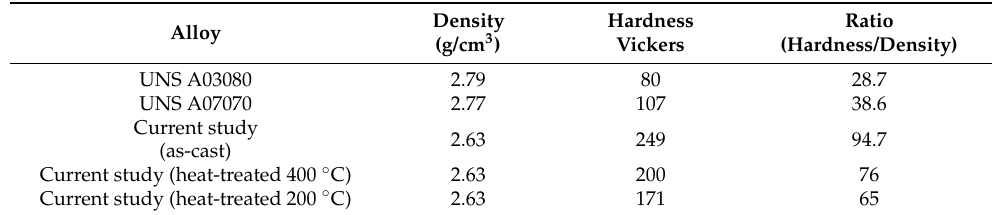
Table 11. Comparative table of microhardness values of the manufactured alloy in as-cast and heat-treated conditions and common cast aluminum alloys.